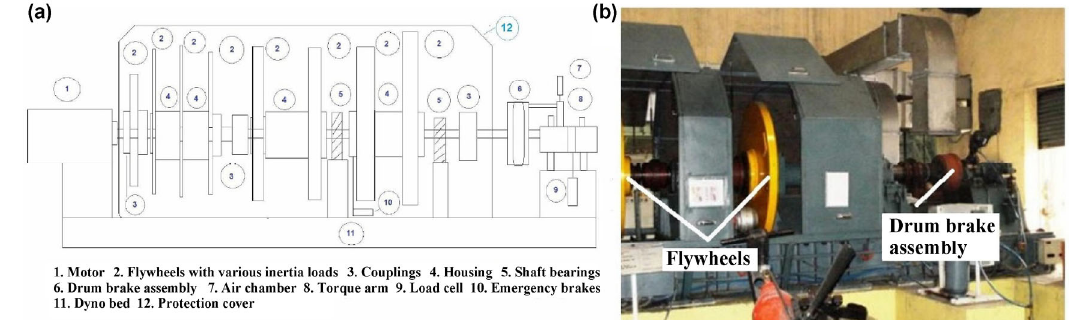
Fig. 3 Single end inertia brake dynamometer (a) schematic view and (b) photographic